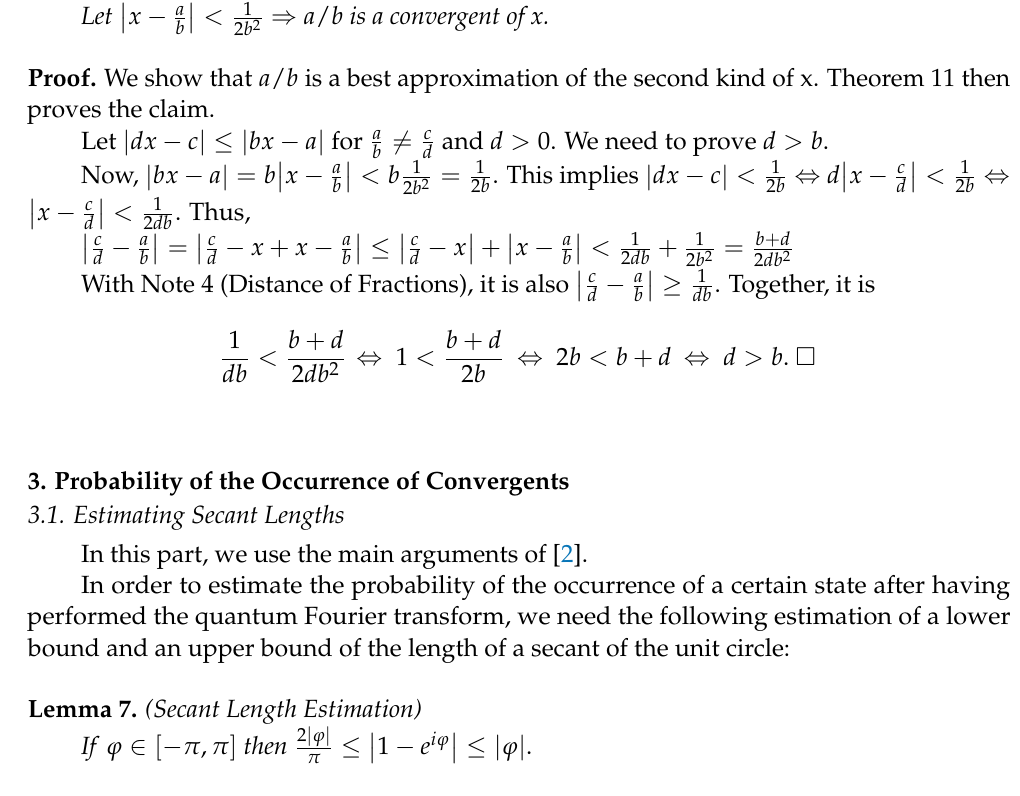
Figure 16. Situation in which a / b is between a convergent and its first semiconvergent ( k even). Finally, we give a simple criterion that allows us to prove that a given fraction is a convergent of another real number. This theorem is a cornerstone of computing a prime factor with Shor’s